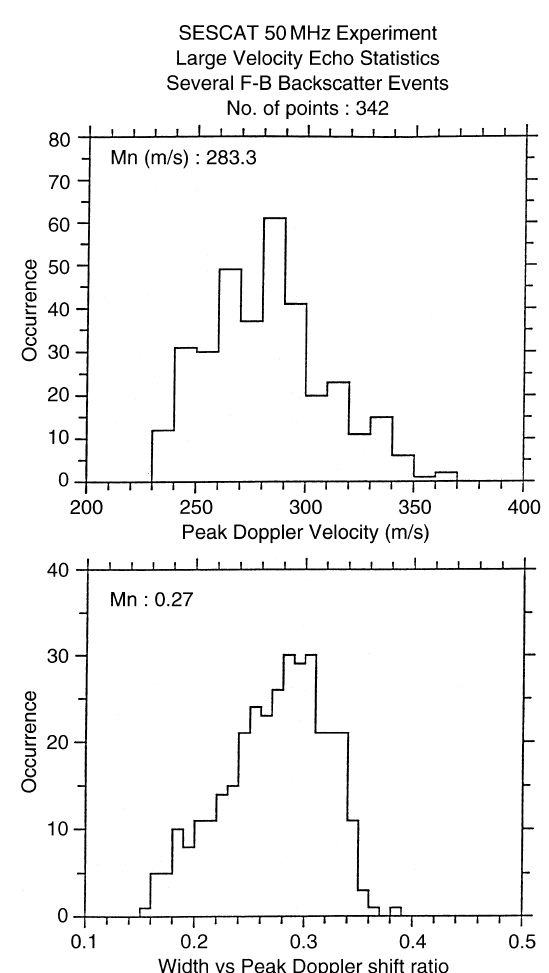
Fig. 7. The distribution of peak phase velocities and spectral widths (width/peak ratios, actually) for mid-latitude type-1 echoes. The mean peak velocity is near 285 m/s, which is about 20% slower than nominal ion-acoustic speeds at 105 km and the type-1 velocities observed at the equator